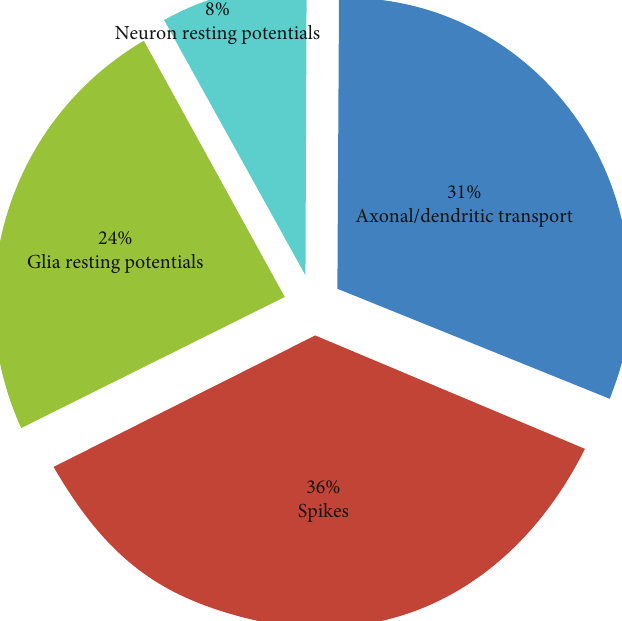
Figure 4: Distribution of energy consumption in neural